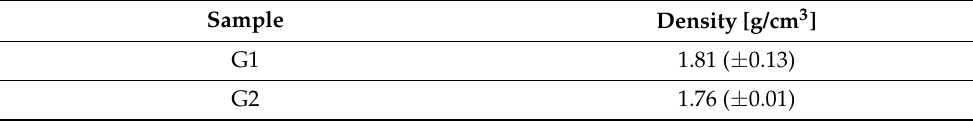
Table 4. Density results of samples.